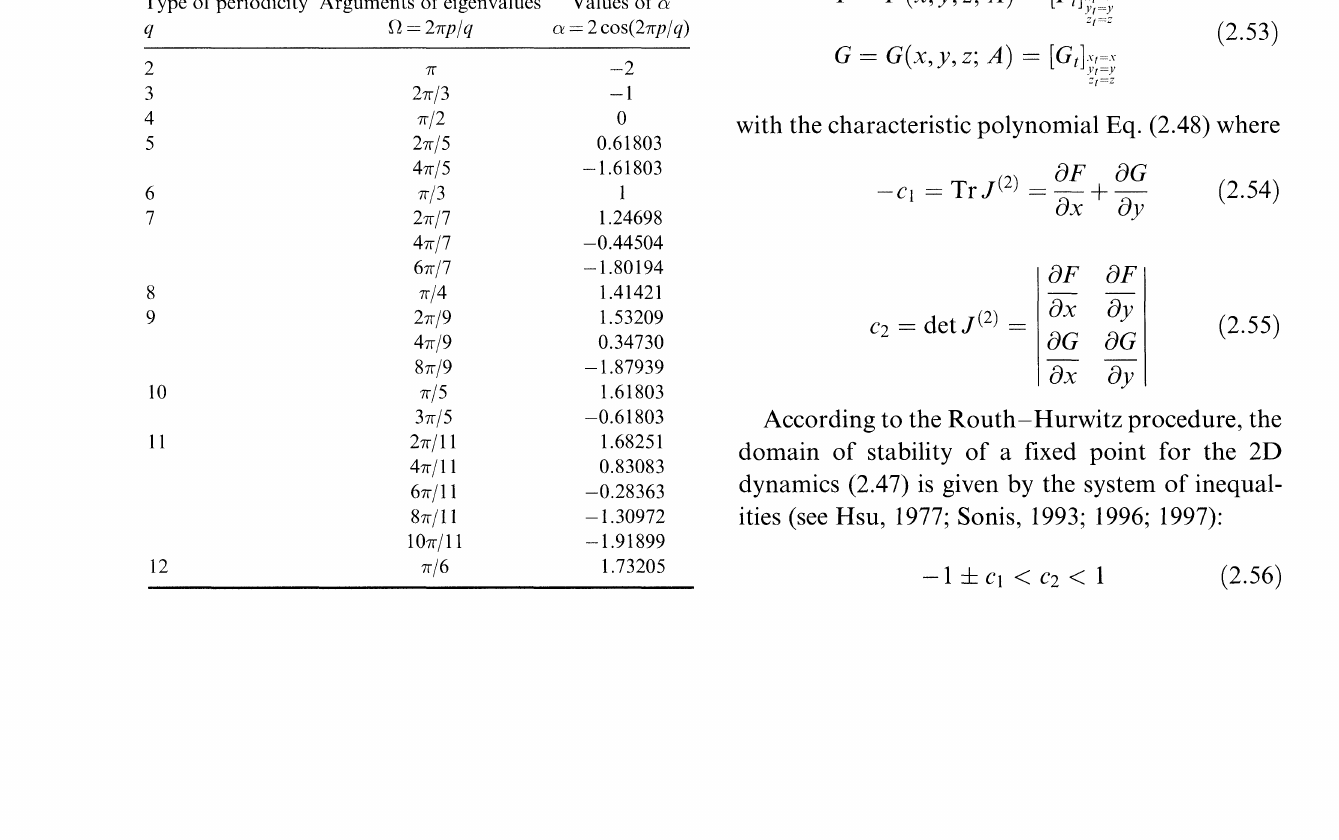
Equilibria generating periodicity (till period 12) Type of periodicity Arguments of eigenvalues Values of